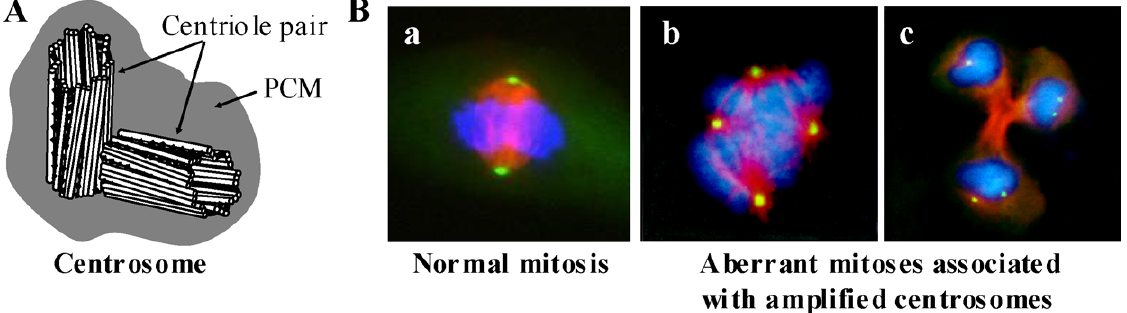
Fig. 1. Centrosome structure and abnormal mitosis caused by amplified